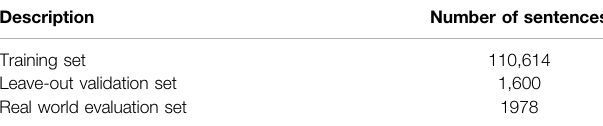
TABLE 1 | Sizes of training, leave-out validation, and real-world evaluation